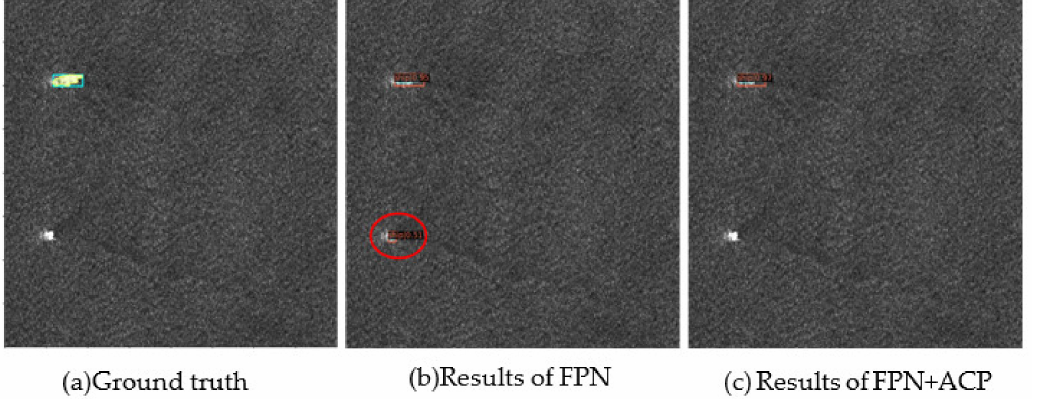
Figure 7. Comparison of performance of FPN and FPN + ACP. ( a ) Ground truth. ( b ) The result of FPN. The red circle indicates a false detection by FPN. ( c ) The result of FPN + ACP, which is in agreement with the ground